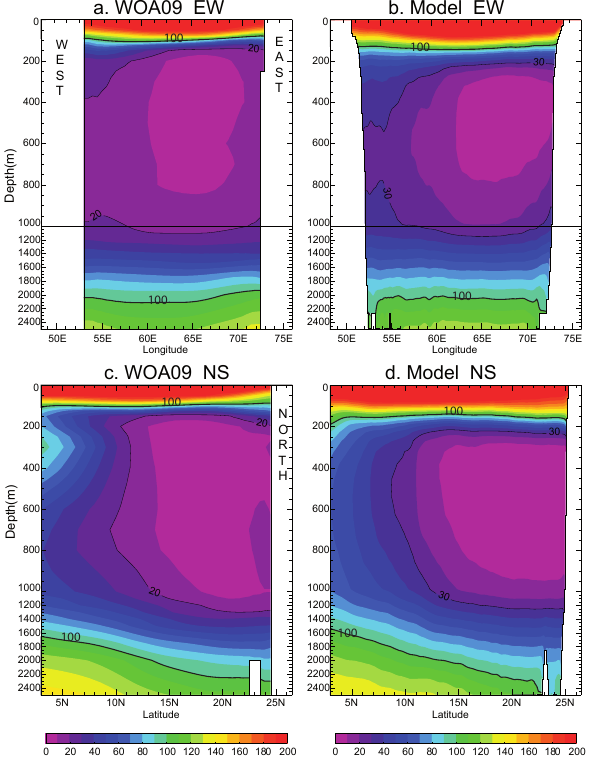
Fig. 4. Annual oxygen concentration (in µmolL − 1 ) along the east–west (EW) and north–south (NS) sections indicated in Fig. 1h in (a) WOA09 climatology and (b) the model.